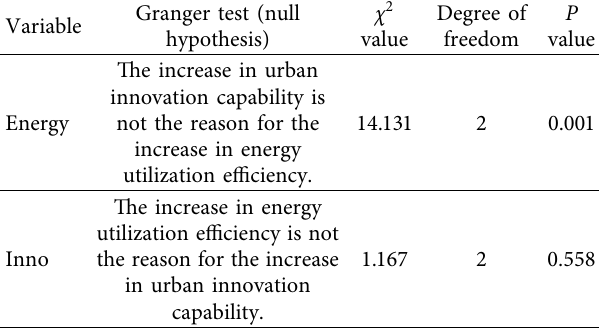
Table 6: Granger causality test.